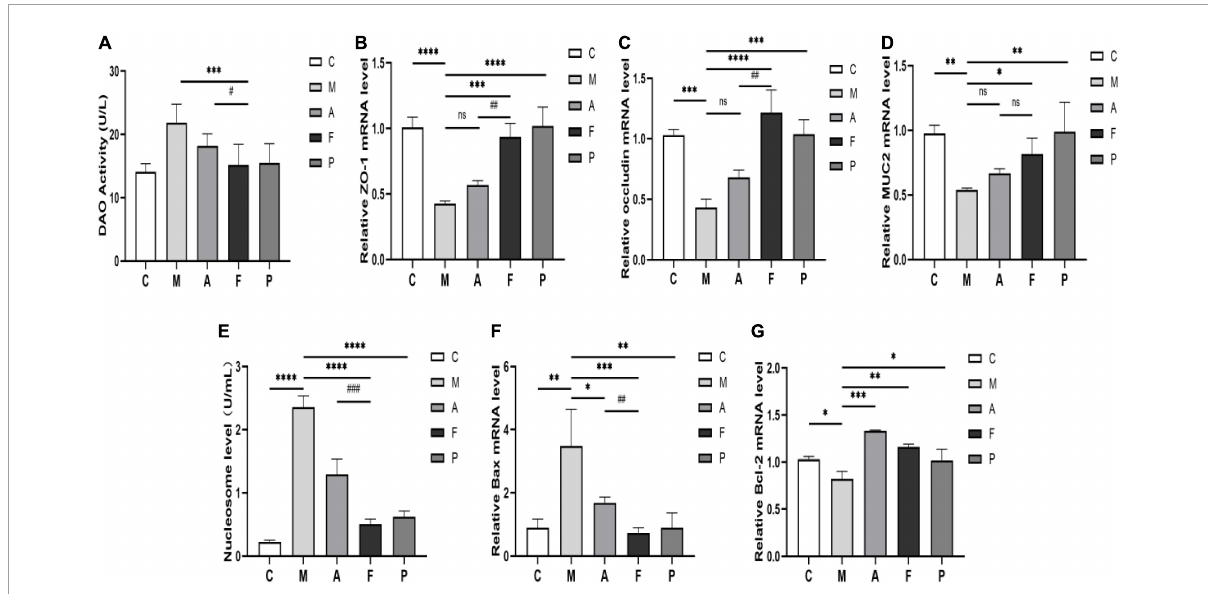
FIGURE5 FA repaired intestinal mucosal barrier structure and ameliorated cells apoptosis in DSS-induced mice: (A) DAO activity in serum; (B) the expression of ZO-1 in colon tissue; (C) occludin; (D) MUC2; (E) the level of the nucleosome in colon tissue; (F) the expression of Bax in colon tissue; (G) Bcl-2. Data are mean ± SD ( n = 3–4). ∗ P ≤ 0.05, ∗∗ P ≤ 0.01, ∗∗∗ P ≤ 0.001, and ∗∗∗∗ P ≤ 0.0001 vs. the M group; # P ≤ 0.05, ## P ≤ 0.01, and ### P ≤ 0.001 vs. the A group. ns, no